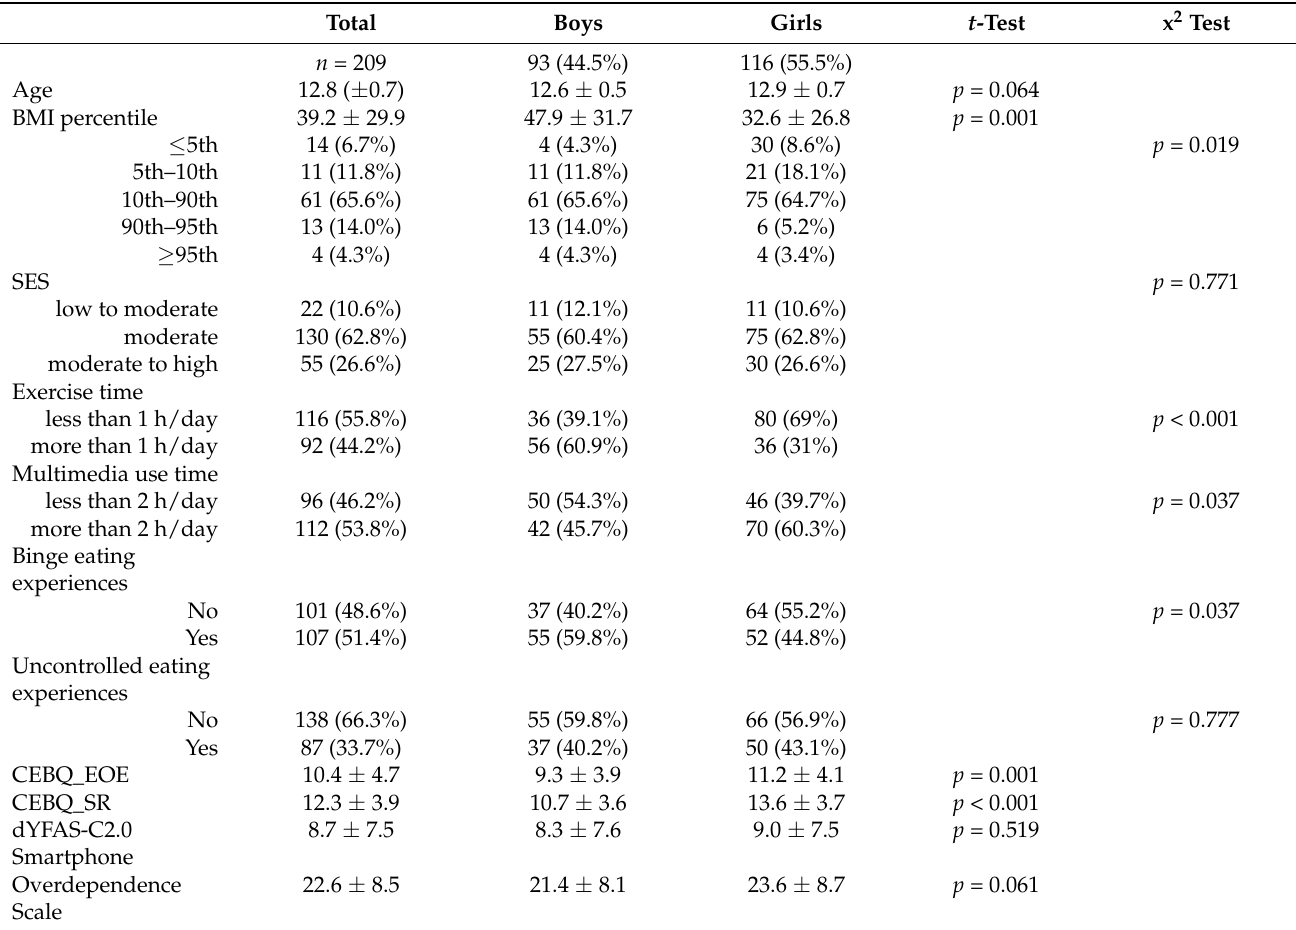
Table 1. Demographic characteristics of